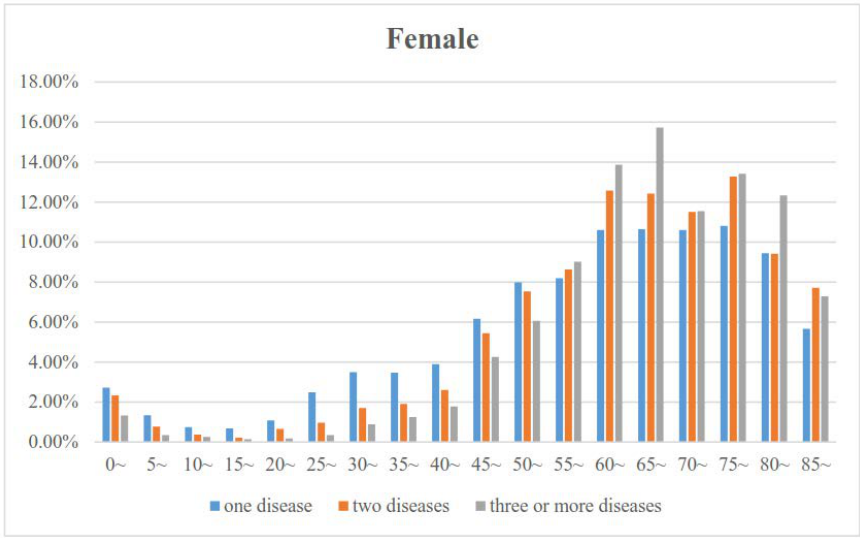
Figure 1. Association between age and the proportion of the number of diseases for females.